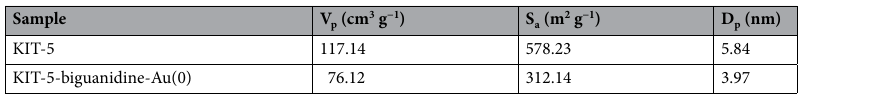
Table 1. N 2 adsorption–desorption analysis summarize of KIT-5 and KIT-5-biguanidine-Au (0) samples.